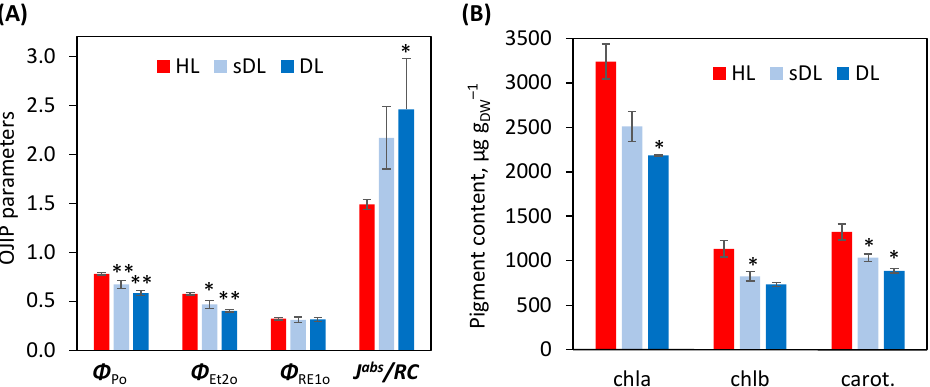
Figure 6. The influence of desiccation on OJIP parameters and the content of photosynthetic-related pigments in R. serbica leaves. ( A ) Φ Po ; equals Fv/Fm- maximum quantum yield of primary PSII photochemistry; Φ Et2o , a measure for the quantum yield of the electron transport flux from Q A to Q B , Φ Re1o is the quantum yield of the electron transport flux until the PSI electron acceptors and J abs /RC is average absorbed photon flux per PSII reaction center. Asterisks denote significant differences between sDL and DL compared to HL according to the Mann–Whitney U - test (* p < 0.05, ** p < 0.01). ( B ) chla, chlorophyll a; chlb, chlorophyll b; carot, carotenoids. Asterisks denote significant differences between sDL and DL compared to HL according to the t -test (* p < 0.05). Values are shown as means ± SE.